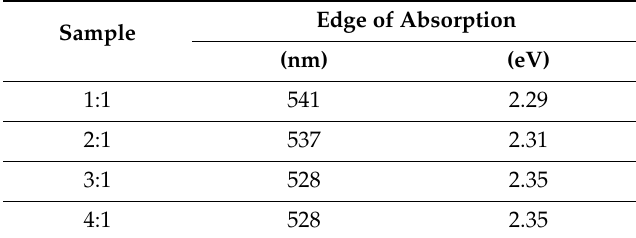
Table 1. Edges of absorption for each samples.